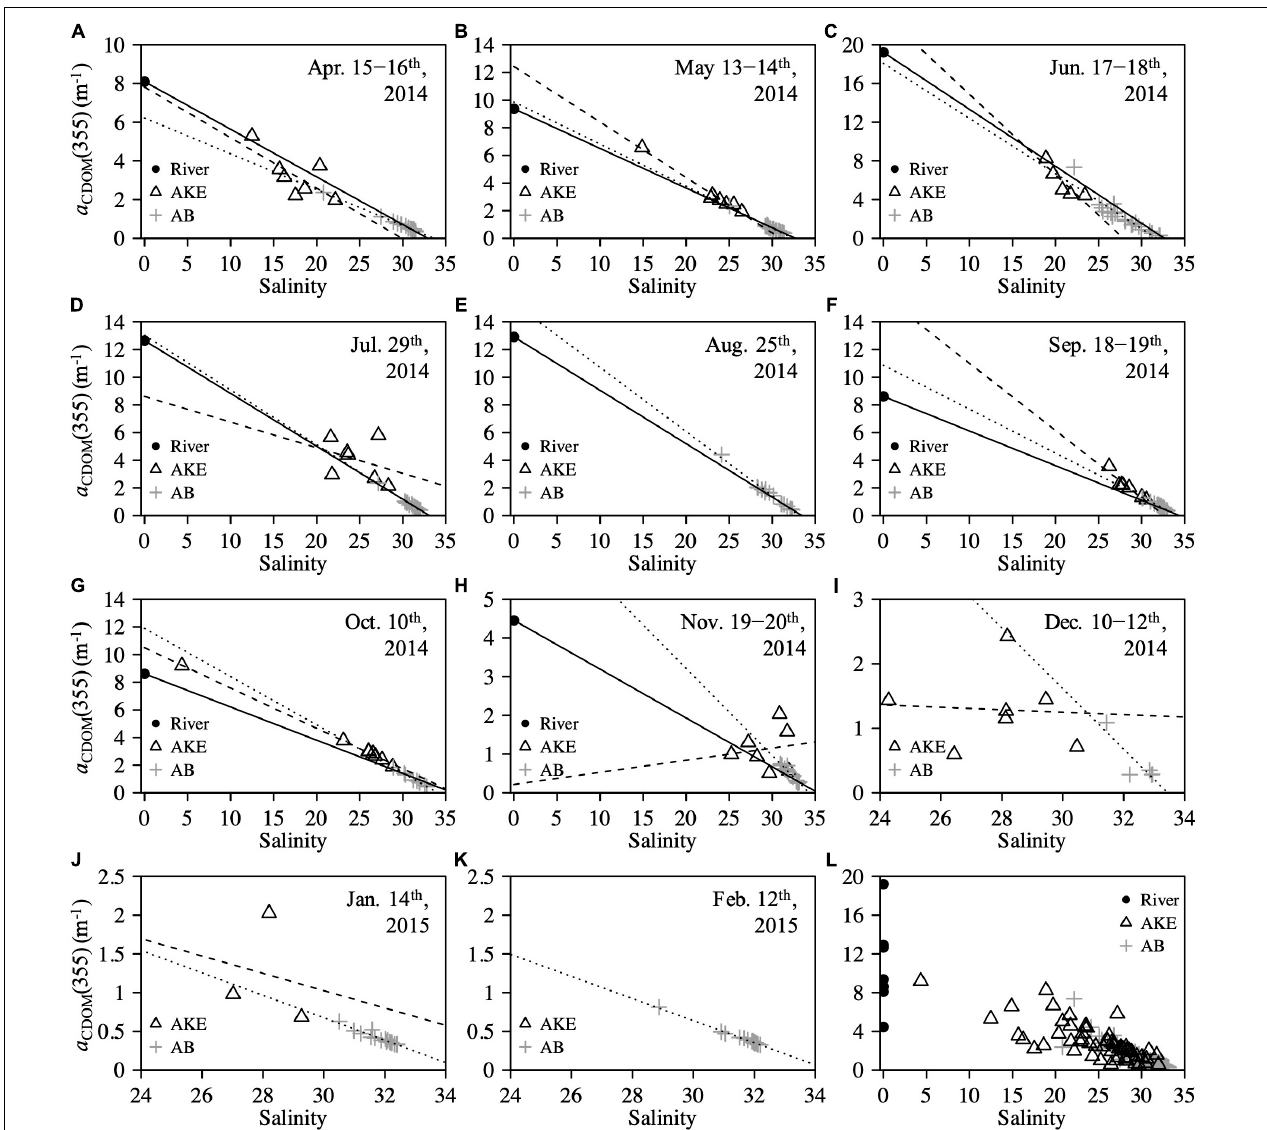
FIGURE 5 | Relationships between salinity and a CDOM (355) at the surface (A–K) from April 2014 to February 2015 and (L) throughout the study period. Solid line in each figure represents the conservative mixing line of two-end-members between freshwater (RB) and coastal water based on salinity. Sample taken in RO was used as the freshwater end-member in (E) August 2014. Dashed and dotted lines represent the regression lines estimated from AKE and AB samples,